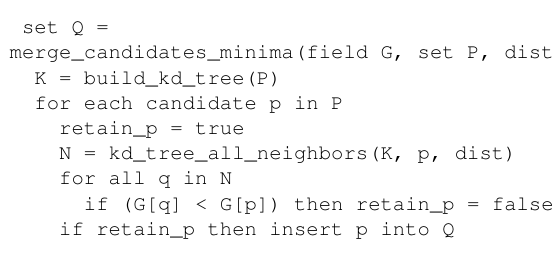
Algorithm 1 Compute the spatial mean value of a field G over a region of radius dist using graph search on an un- structured grid.